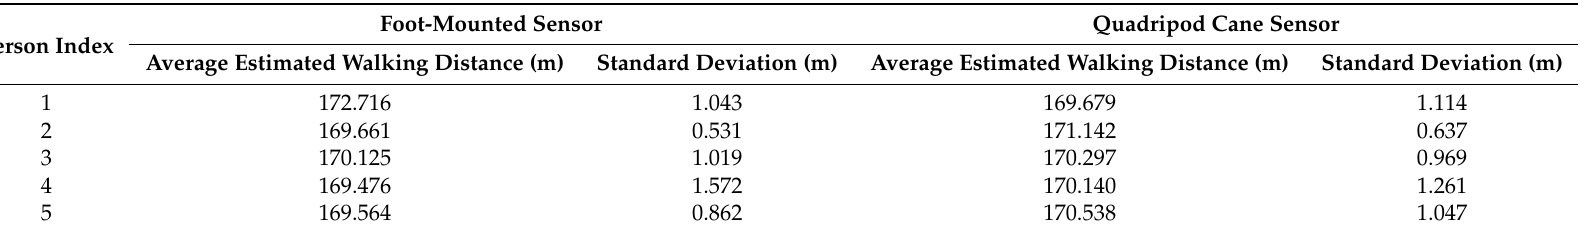
Table 3. Estimated walking distance from 170-meter experiment with quadripod cane.